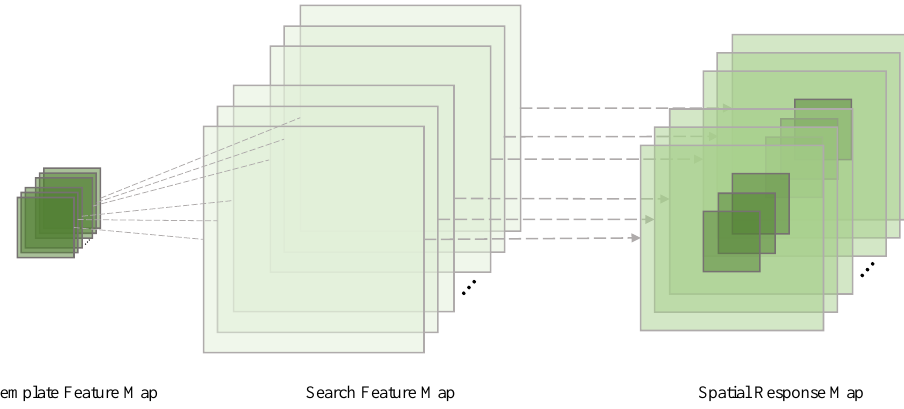
Figure 4. Spatial cross-correlation